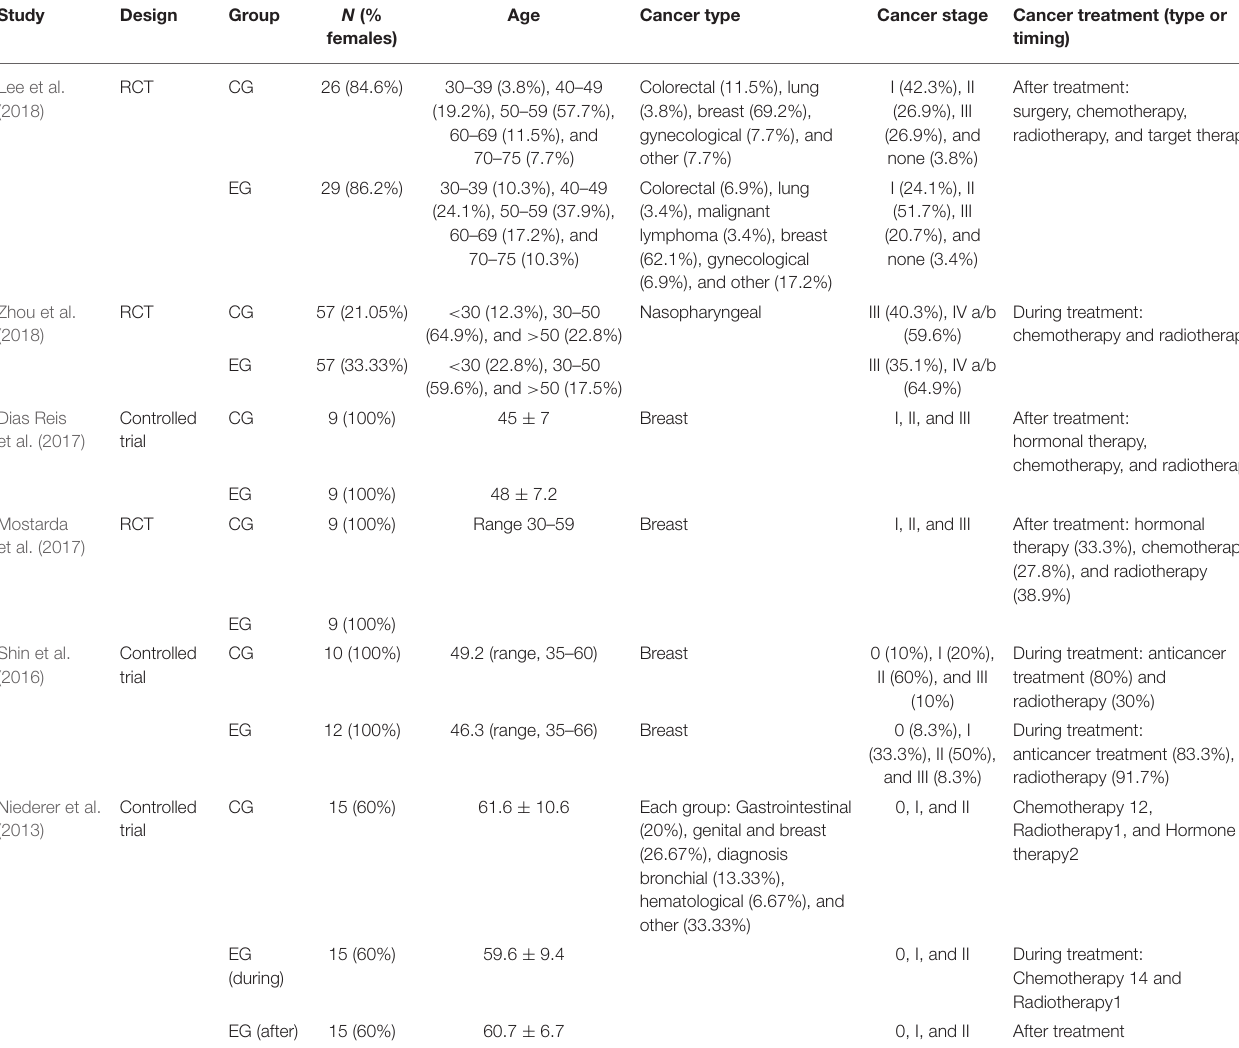
TABLE 2 | Baseline characteristics of